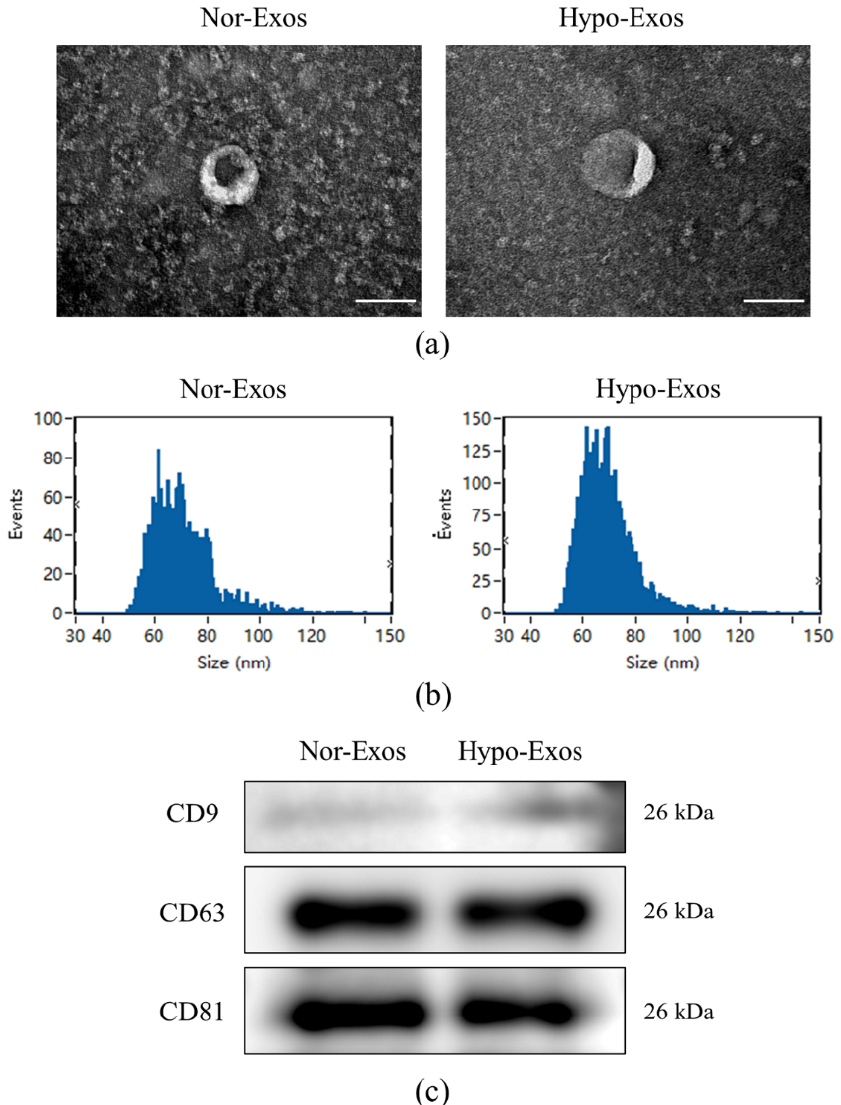
Figure 2. Characterization of Nor-Exos and Hypo-Exos. ( a ) Morphology of Nor-Exos and Hypo- Exos under TEM. ( b ) Diameter distribution of Nor-Exos and Hypo-Exos assessed by NanoFCM. ( c ) Exosomal surface markers CD9, CD63 and CD81 were detected by Western blot analysis. Scale bars: 100 nm ( a ).